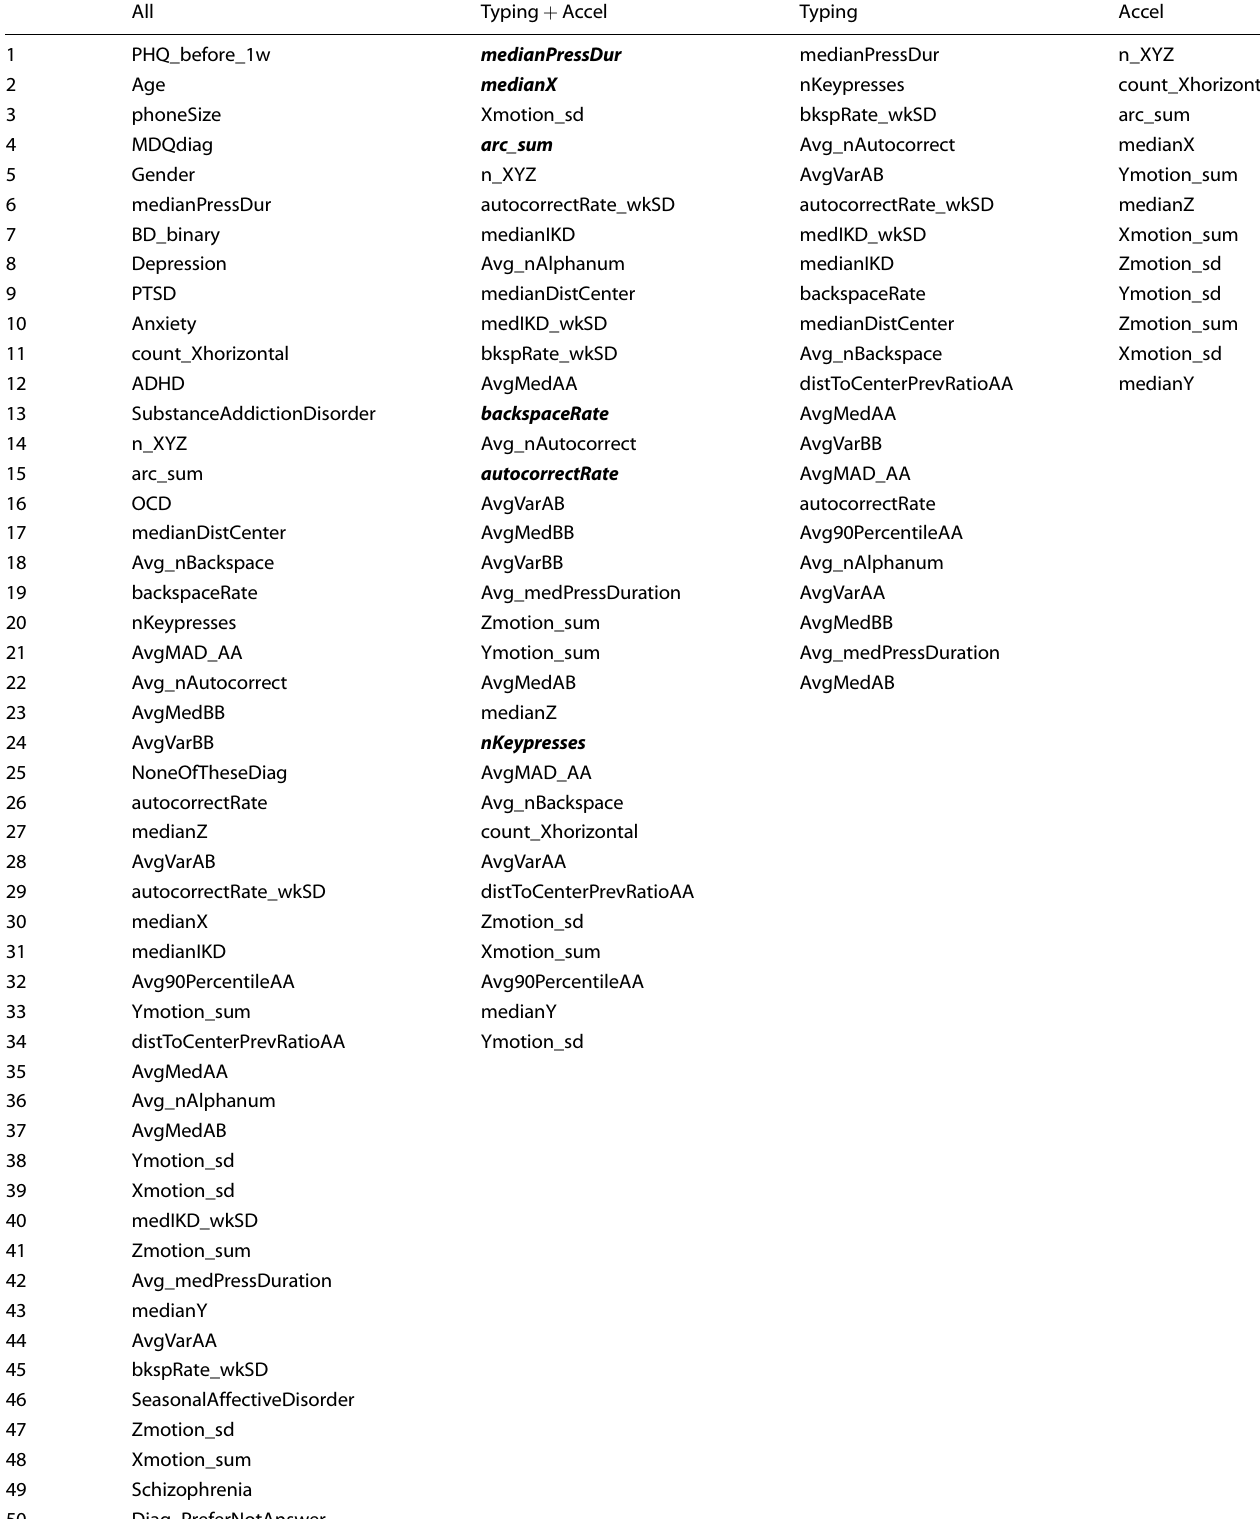
Table 4. Feature rankings by data slice a . All Typing + Accel Typing